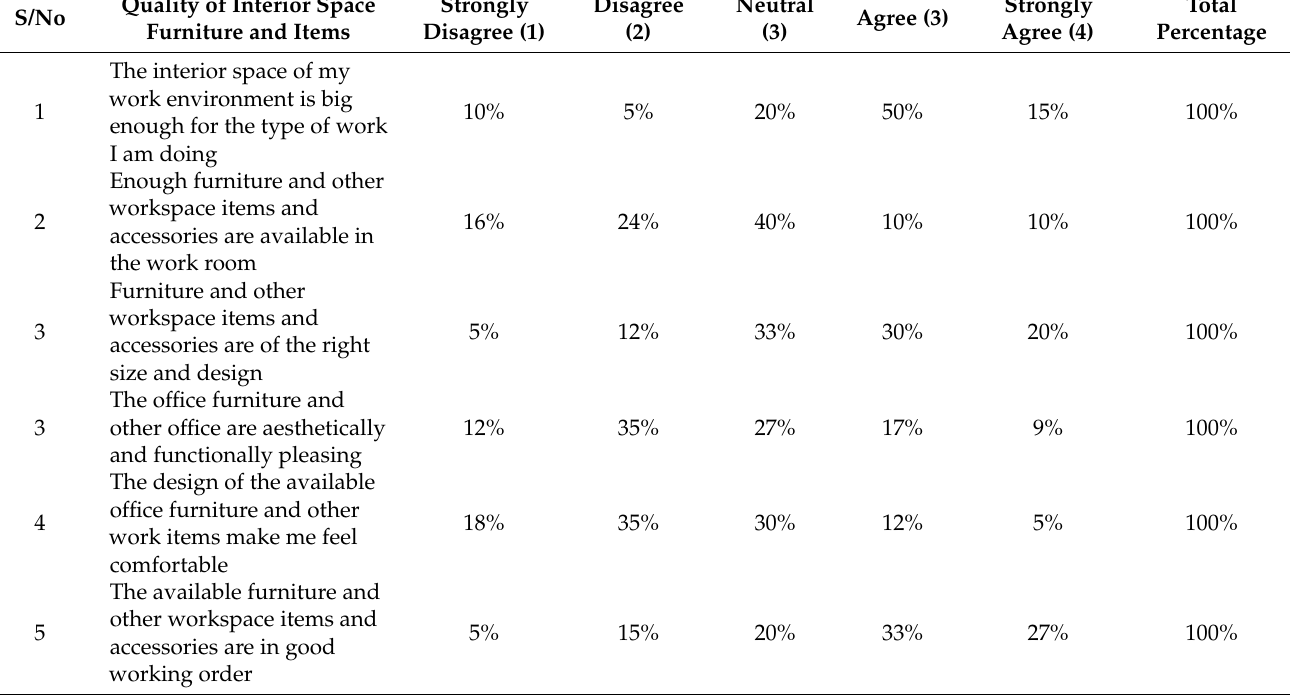
Table 2. Results of assessment of the quality of interior space furniture and